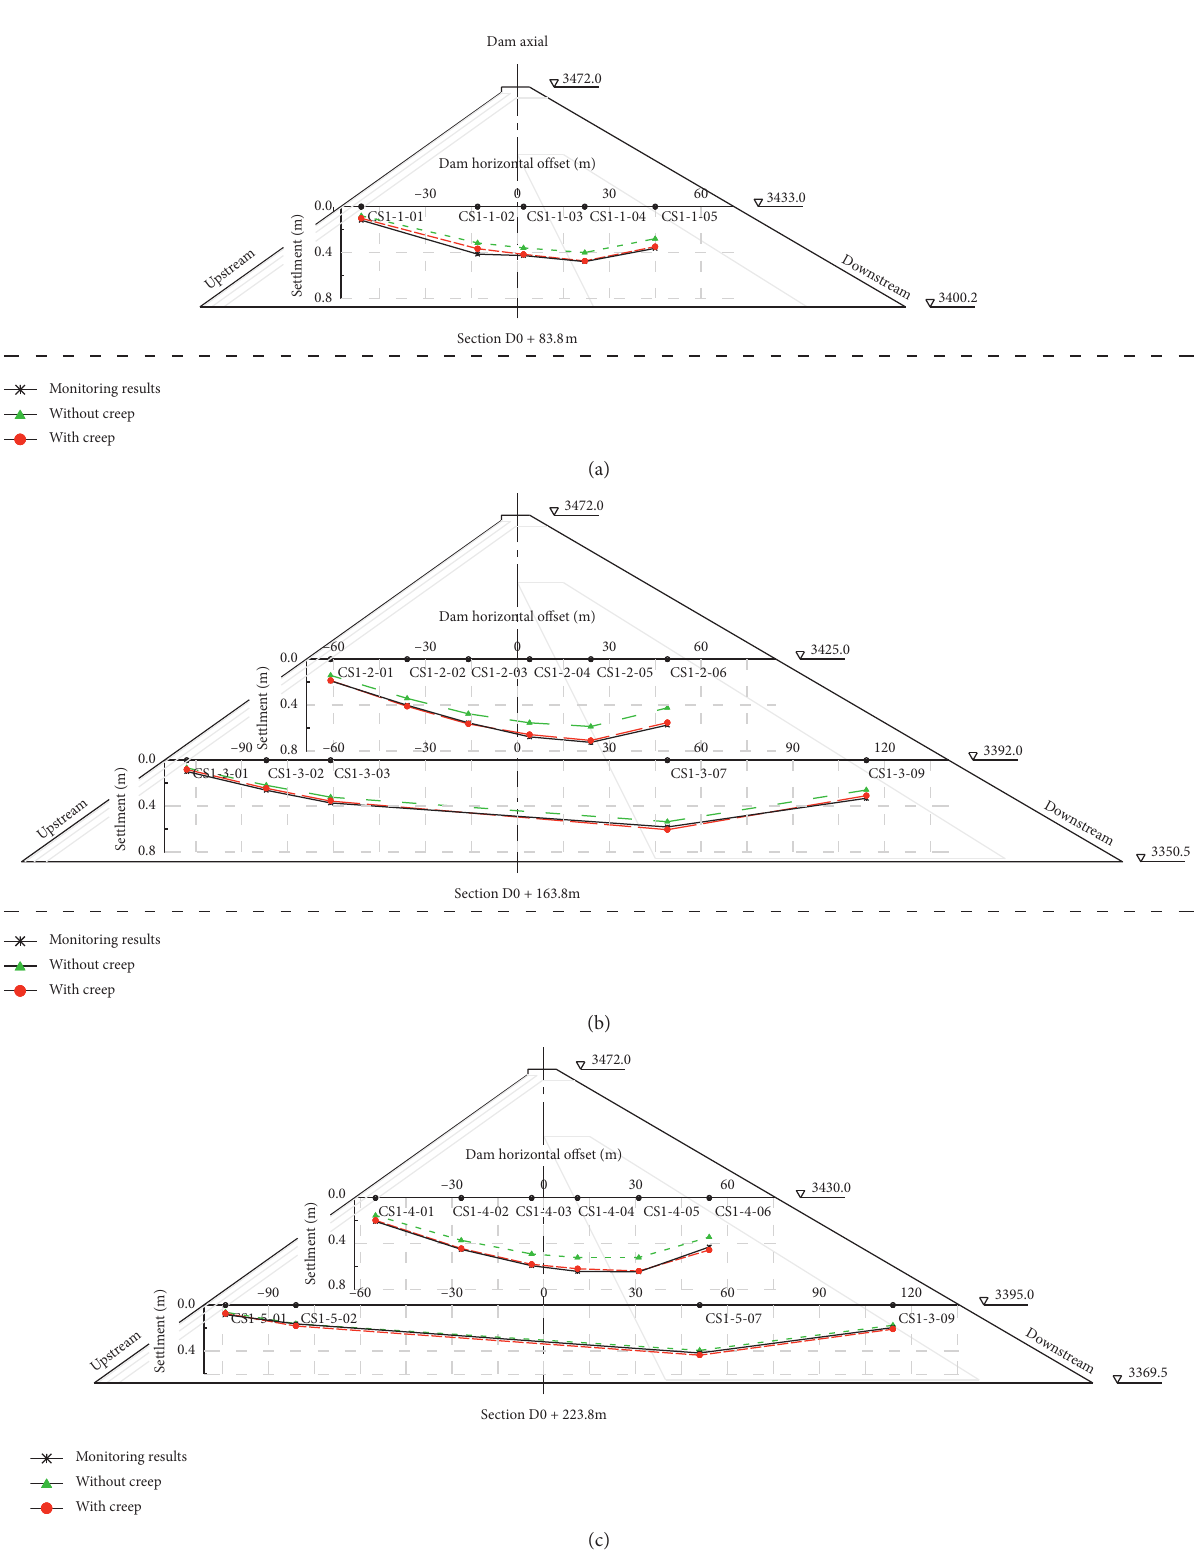
Figure 7: Comparison of dam body settlement eight months before and after the completion of filling (CS1